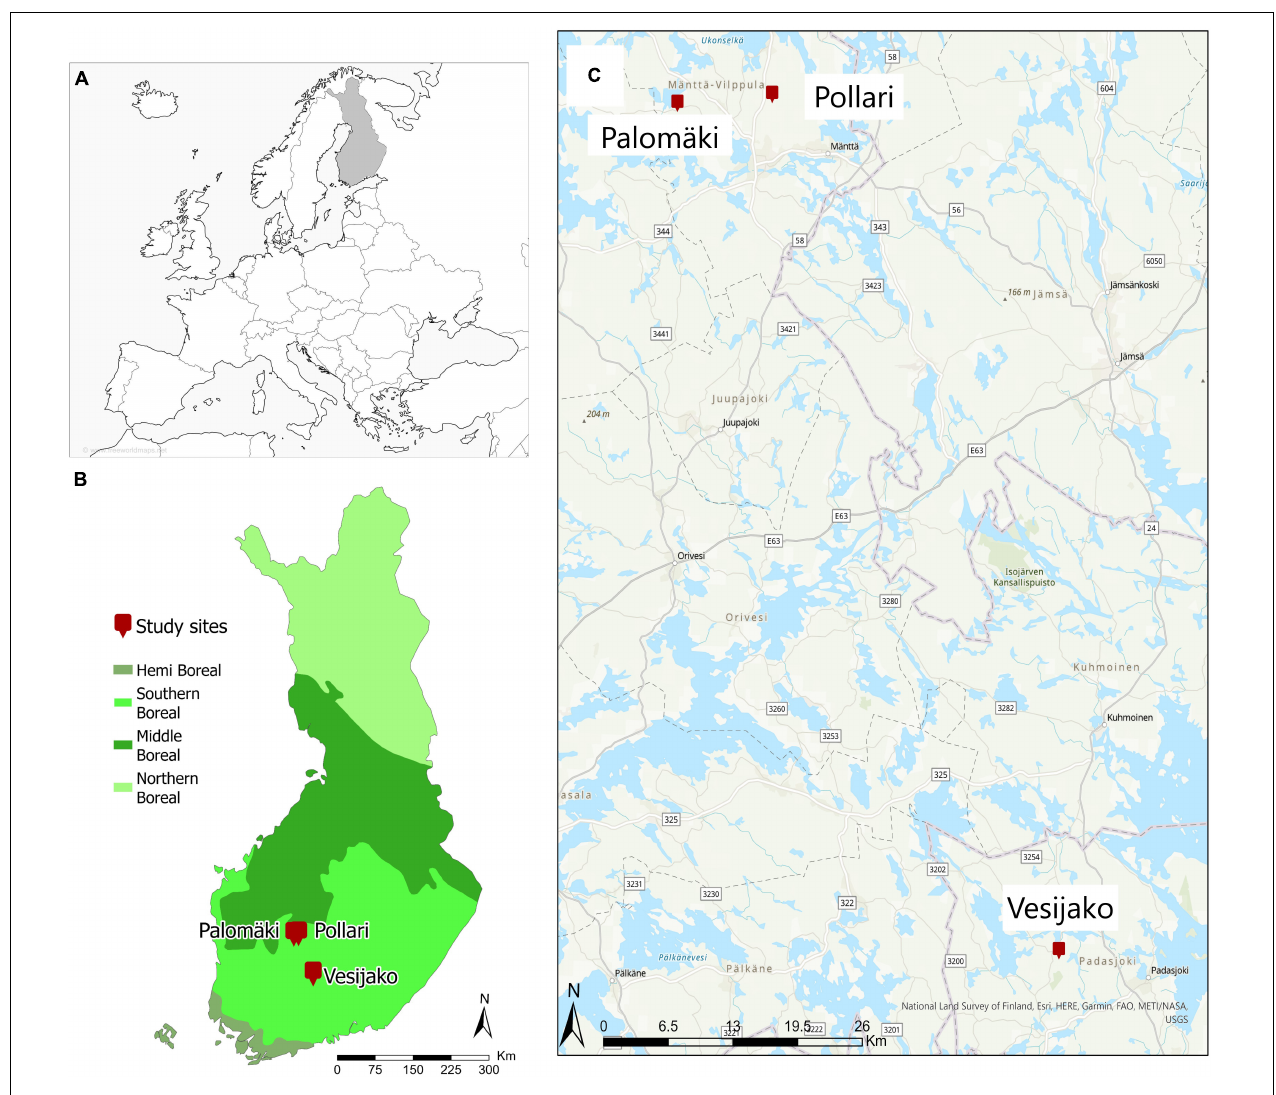
FIGURE 1 | Location of tree study sites (i.e., Palomäki, Pollari, and Vesijako) and vegetation zones in Finland (A,B) and study sites on top of a base map (C) . © National Land Survey of Finland, Esri, HERE, Garmin, FAQ, METI/NASA, and USGS